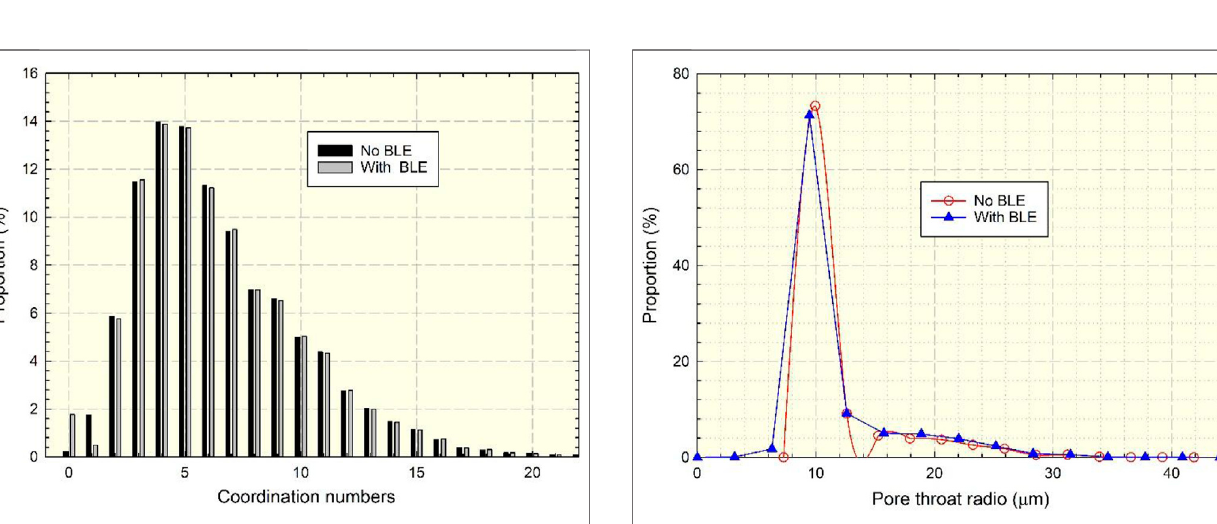
FIGURE 14 | Comparison of effective connections between pores and throats. (A) Without BLE and (B) with BLE.